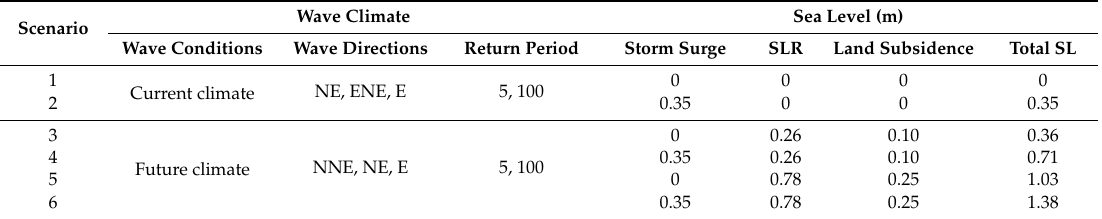
Table 1. Characteristics of the studied scenarios. Wave conditions refer to significant wave height Hs and peak period Tp. Return periods (in years) refer to those from the extreme wave